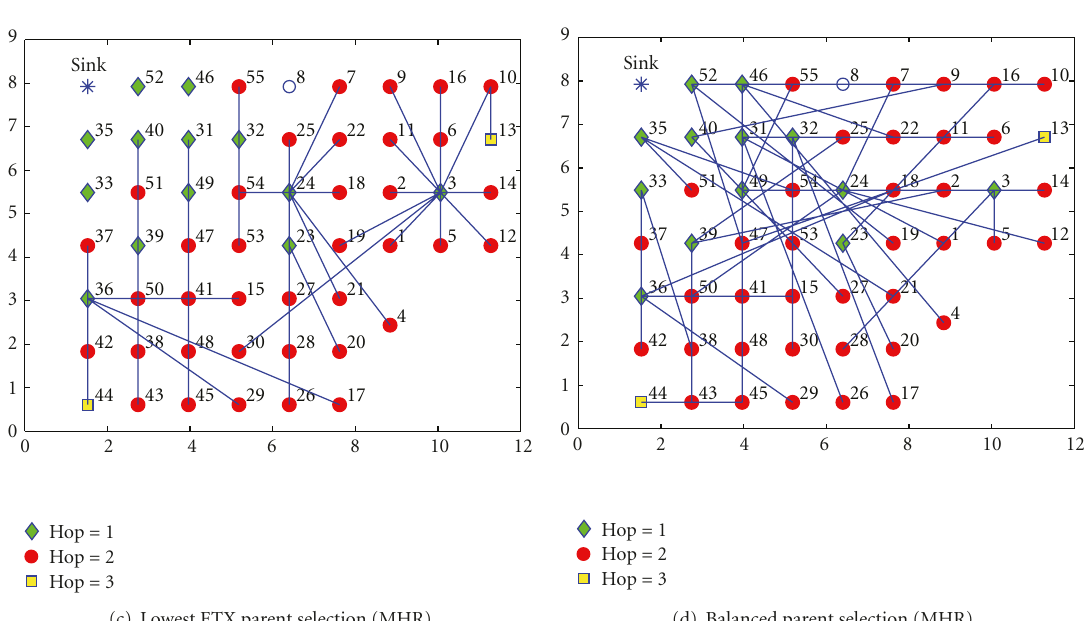
(d) Balanced parent selection (MHR) Figure 2: The indoor deployment location of nodes and four data-gathering topology maps with localized tree construction schemes using the PRR data obtained by UCLA/CENS group: (a) the lowest ETX parent selection, (b) the random parent selection scheme (all possible links) with MHR, (c) the lowest ETX parent selection scheme with MHR, and (d) the balanced parent selection scheme with